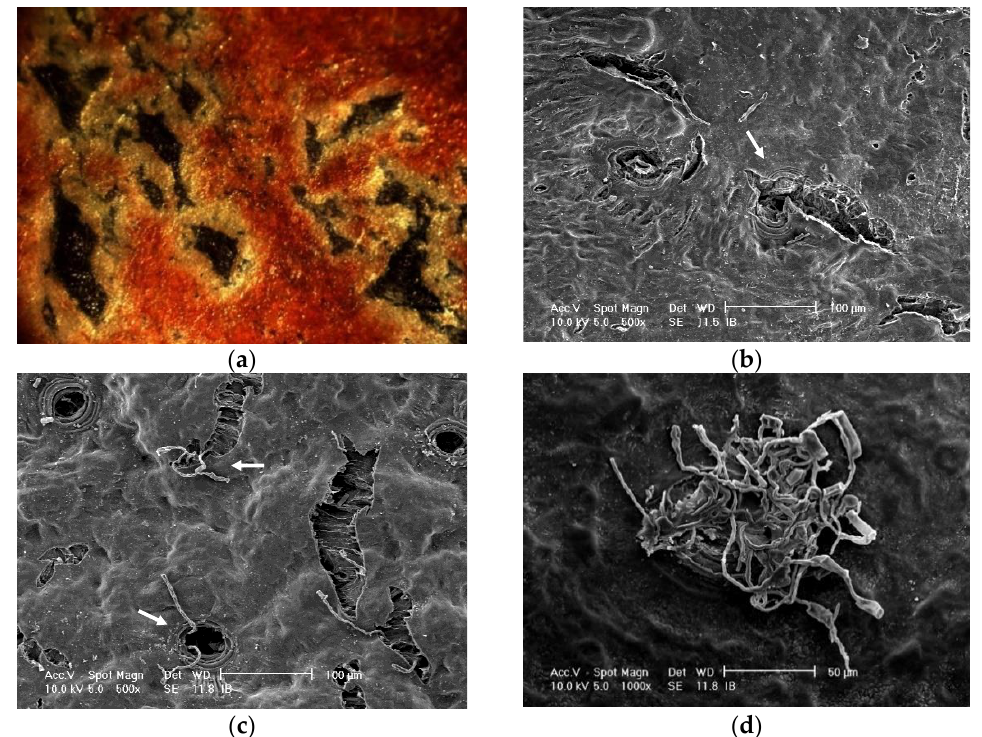
Figure 1. ( a ) Surface of the nectarine fruit ‘Zéphir’ at maturity with a dense network of microcracks under a stereomicroscope. Cracks were stained dark blue by applying toluidine blue at 0.1%. ( b ) Scanning electron microscopy image showing microcracks originating from a lenticel, presumably derived from a stoma (arrow) on the fruit peel of nectarine ‘C222’ selection. ( c ) Scanning Electron Microscopy image showing spores of M. laxa germinating (arrows) in the microcracks of mature nectarine fruit of cultivar Magic. ( d ) Scanning Electron Microscopy showing the development of M. laxa mycelia in a lenticel on the fruit peel of ‘C222’ selection.